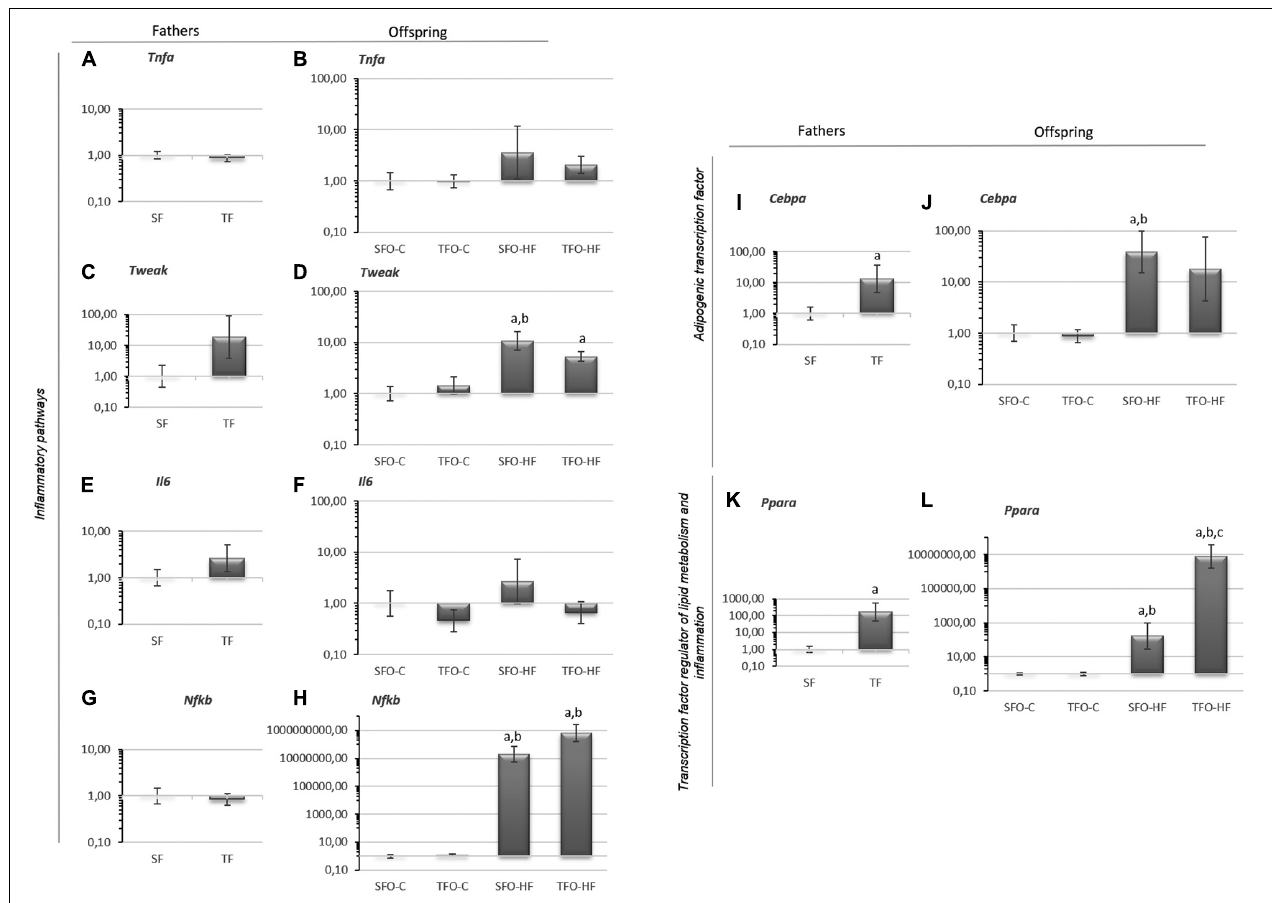
FIGURE 4 | Inflammatory pathways, adipogenic transcription factor and transcription factor regulator of lipid metabolism mRNA levels in the gastrocnemius muscle of fathers and offspring exposed to control diet and HFD. (A,B) Tumor necrosis factor alpha ( Tnfa ). (C,D) Tumor necrosis factor ligand superfamily member 12 ( Tweak ). (E,F) Interleukin-6 ( Il6 ). (G,H) Factor nuclear kappa B ( Nfkb ). (I,J) CCAAT/enhancer binding protein ( Cebpa ). (K,L) Peroxisome proliferator-activated receptor ( Ppara ). The data are geometric mean ± standard error. The expression level is represented by the 2 − (cid:49)(cid:49) CT . SF, sedentary fathers; TF, trained fathers; SFO-C, offspring from sedentary fathers, exposed to control diet; TFO-C, offspring from trained fathers exposed to control diet; SFO-HF, offspring from sedentary fathers exposed to high-fat diet; TFO-HF, offspring from trained fathers exposed to a high-fat diet. Statistically significant differences compared to: a SFO-C; b TFO-C; c SFO-HF, p ≤ 0.05 ( n = 7 per